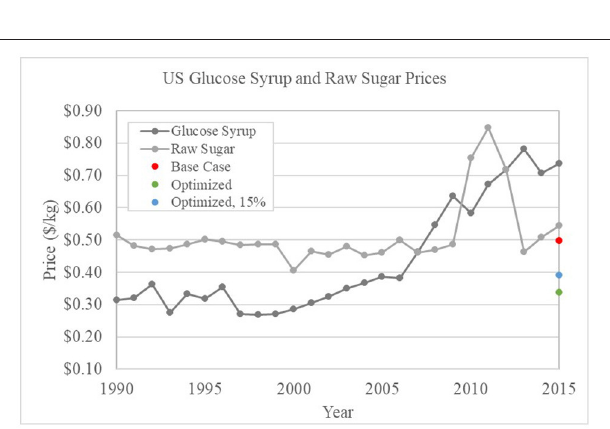
FIGURE 6 | Fiscal year USDA US glucose syrup and raw sugar prices with the micronized base case, optimized and high IRR optimized sugar